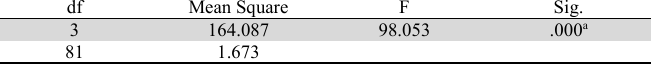
Feasibility Test (F- Test) Model Sum of Squares df Mean Square